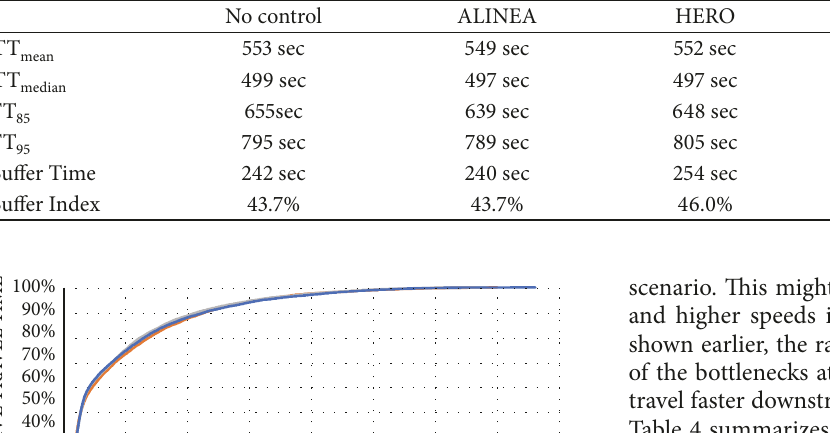
Table 3: Mean, median, 85 th percentile, 95 th percentile travel time, buffer time, and buffer index for the no control, ALINEA, and HERO ramp control for the facility.